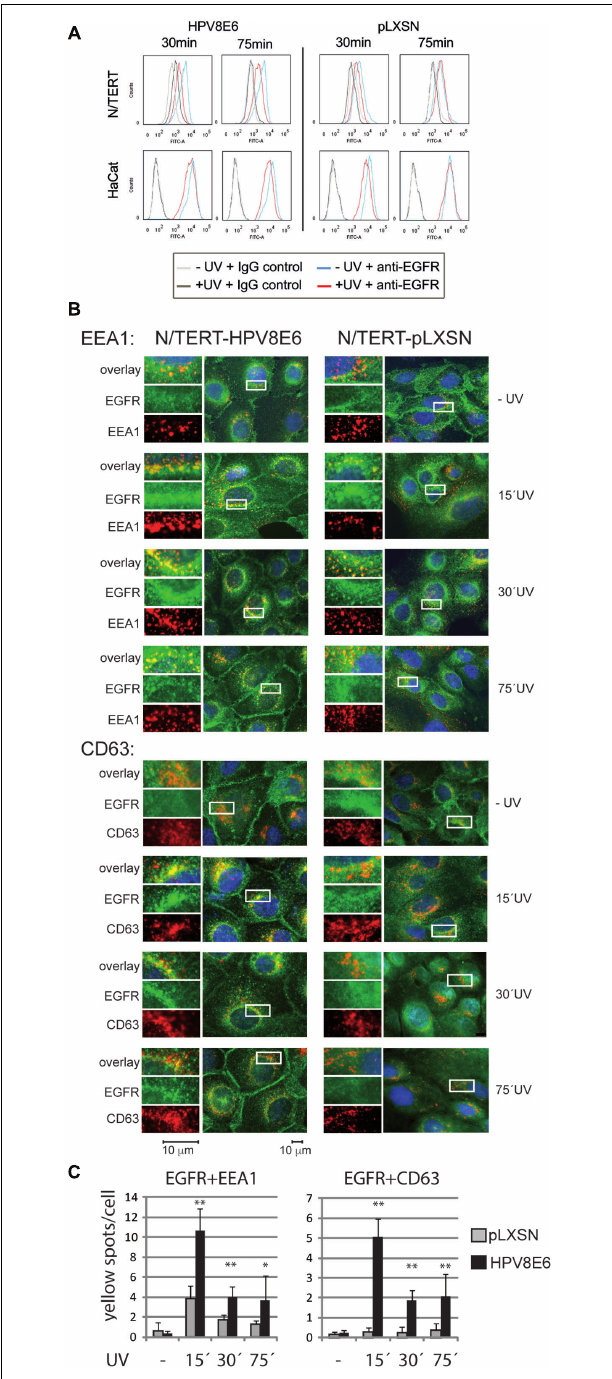
FIGURE 2 | HPV8E6 alters the intracellular trafficking of the EGFR after UV-irradiation. (A) FACS analysis of fixed and non-permeabilized pLXSN-empty vector or HPV8E6-NTERT and HaCat cells. Cells were left untreated or irradiated with a dose of UV-light of 40 mJ/cm 2 and harvested 30 or 75 min after UV-exposure. The cells were stained with the anti-EGFR-AF488 or the isotype control IgG-AF488 coupled antibody. The graphs represent the overlays of the EGFR-positive non-irradiated cells (blue line) with those harvested 30 min or 75 min post UV (red line),